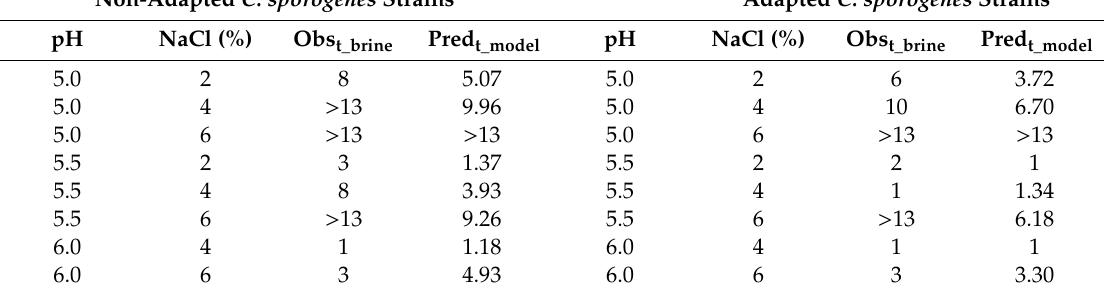
Table 6. Comparison between the observed time to germination in table olive brines (Obs t_brine ) of non-adapted and acid adapted C. sporogenes strains and those predicted (Pred t_model ) by the logistic